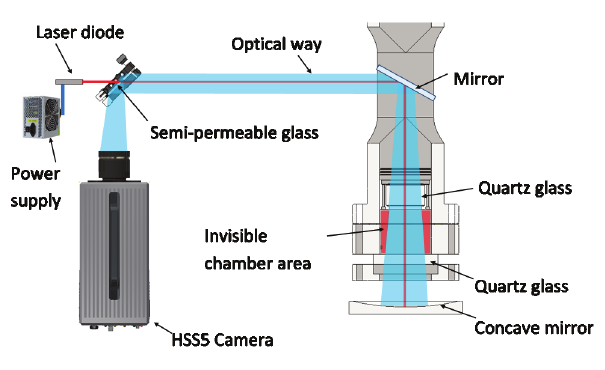
Fig. 9. Test bench construction schematic [6]